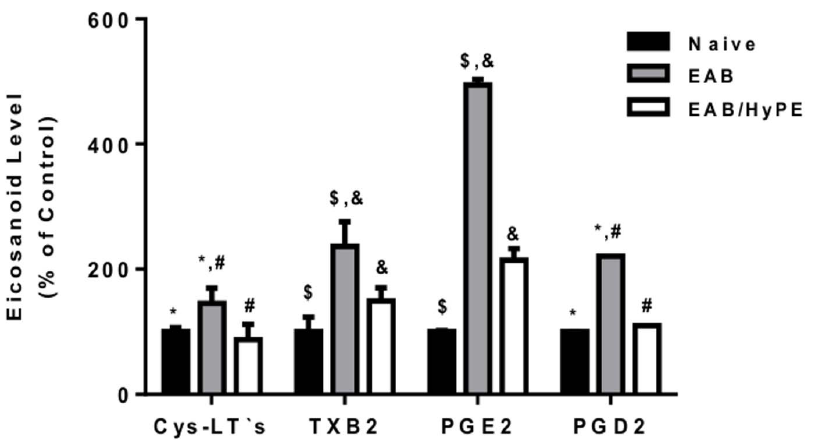
Figure 6. Eicosanoid level in BAL of EAB mice. Eicosanoids in the mice BAL were determined by ELISA. Results are percent change relative to control (100%). The absolute control levels (100%) were 51.47 pg/ml for Cys-LTs, 101.83 ng/ml for TXB 2 , 7.85 ng/ml for PGE 2 and 378.11 pg/ml for PGD 2 . Data are mean 6 SEM for 10 mice. *, # , P , 0.05; $ , &, P , 0.01.